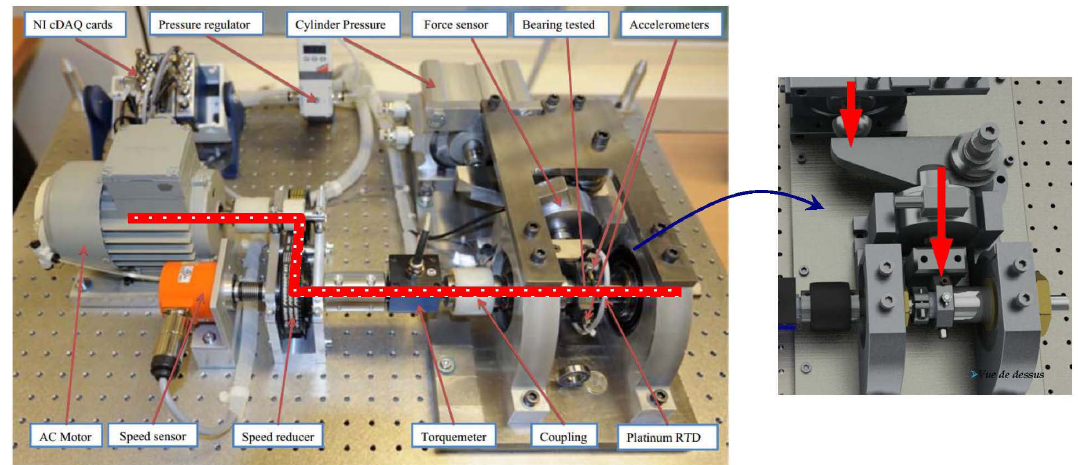
Figure 7. The experimental PRONOSTIA platform for accelerated bearing degradation tests [9].